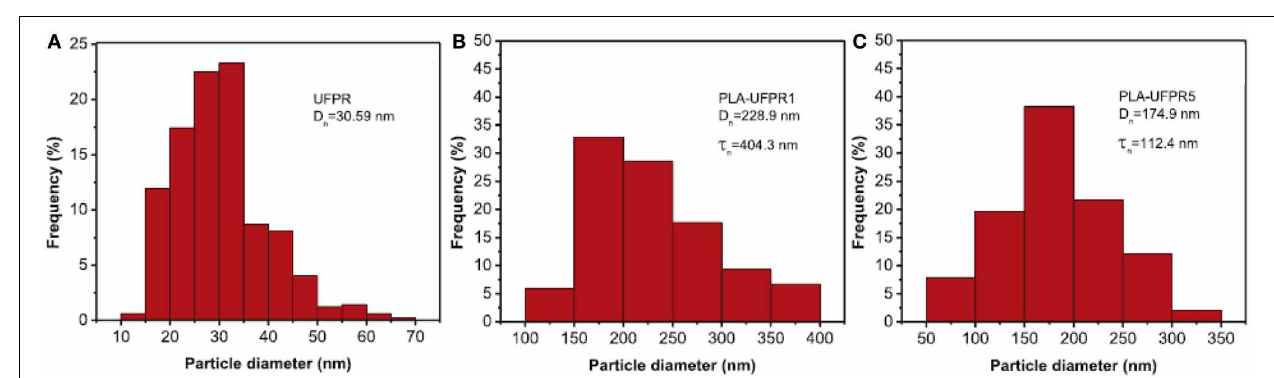
Frontiers in Chemistry | Polymer